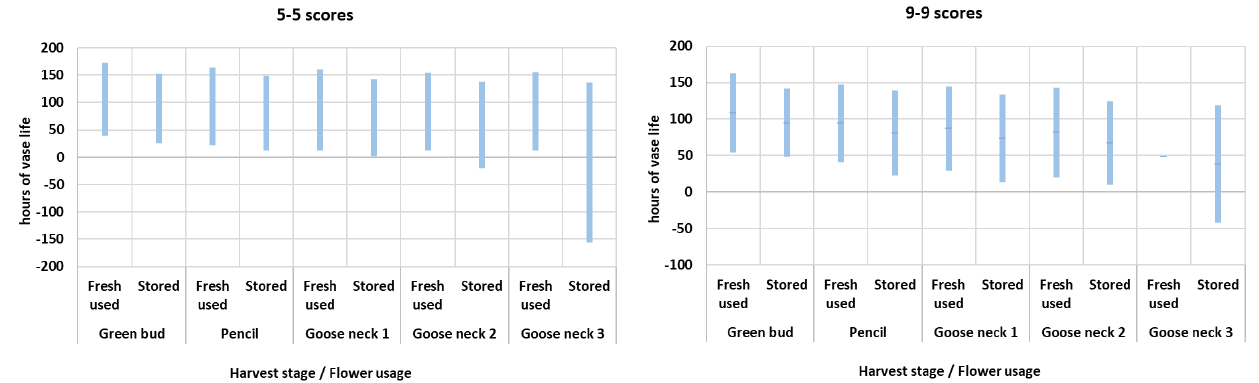
Figure 9. Duration of the usable period of flowers based on ornamental score limits. Bud stages: green bud (GB); pencil: white bud, upright (PE); goose neck 1: white bud, skew (GN1); goose neck 2: white bud, horizontal (GN2); goose neck 3: big white bud, horizontal, maximum with 1 opening petal (GN3). The flowers harvested at the PE, GN1, and GN2 stages, when freshly used in the order of their development at harvest, initially increased in ornamental value, reaching a value approaching 10, with a difference of about 12 – 12 h. The order of wilting was also related to the order of development at harvest (flowers picked at the GN2 stage wilted fastest, followed by GN1 and then the PE buds). After storage, all the flowers in the vases approached the value of 10 points relatively quickly for all three of these picking states. They